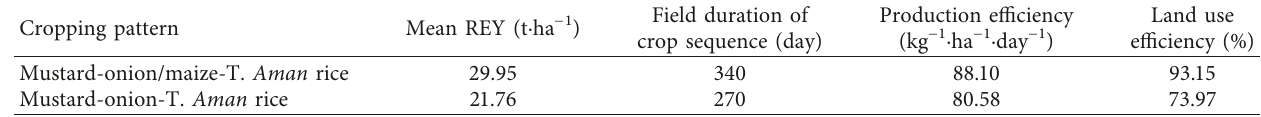
Table 6: Profitability of the four crops pattern over the existing pattern. Cropping pattern Mustard-onion/maize-T. Aman